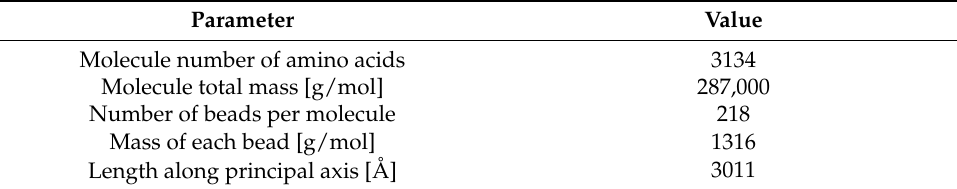
Table 1. Properties of tropocollagen